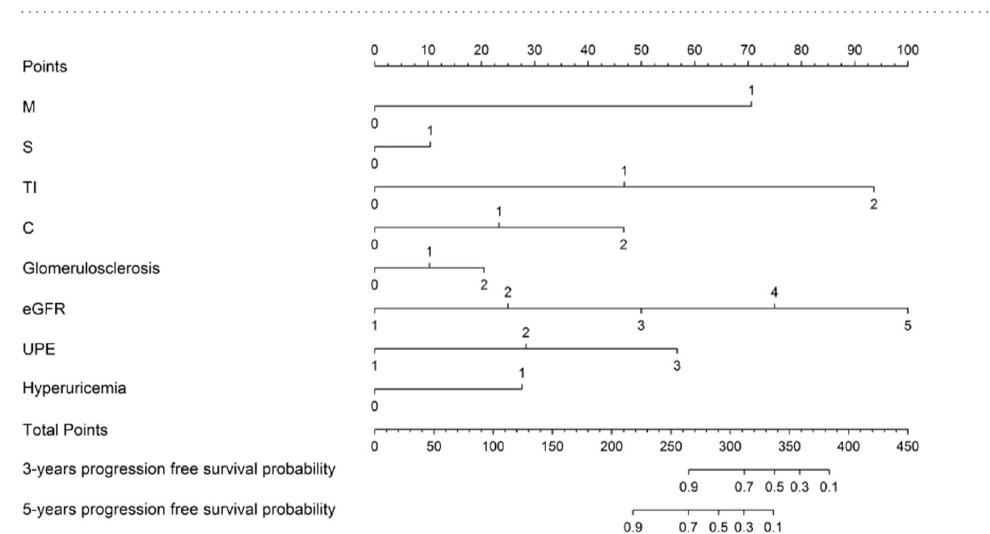
Figure 1. Nomogram for predicting the 3- and 5-year prognosis of IgAN patients. The nomogram was applied by summing the points identified on the points scale for each variable. According to the total points on the bottom scales, the nomogram provides the probability of the 3- and 5-year prognosis for an individual patient. Abbreviation: M, mesangial hypercellularity; E, endocapillary hypercellularity; S, segmental glomerulosclerosis, TI, tubular atrophy/interstitial fibrosis, C, crescents; eGFR, estimated glomerular filtration rate; UPE, urinary protein